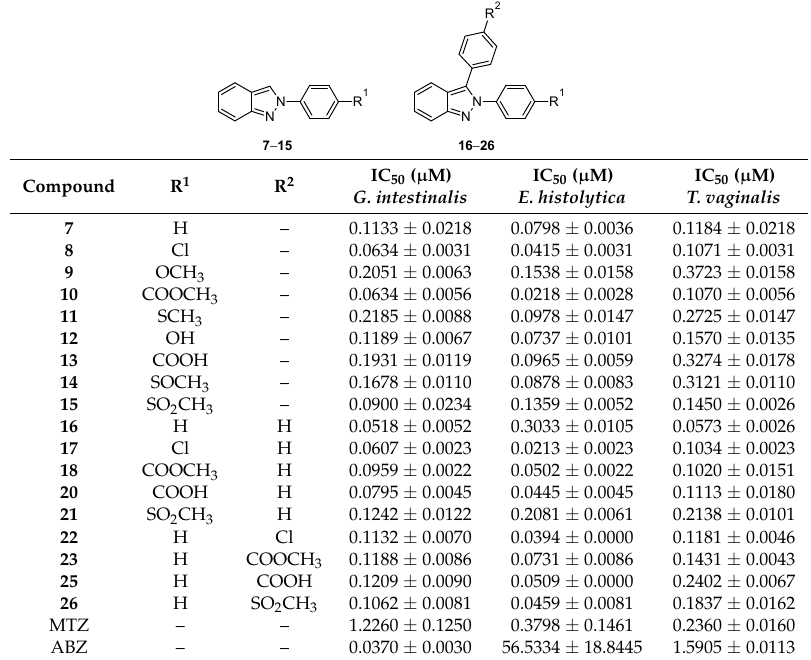
Molecules 2017 , 22 , 1864 Table 1. Antiprotozoal activity of 2-pheny-2 H -indazole derivatives and 2,3-diphenyl-2 H -indazole derivatives. Table 1. Antiprotozoalactivityof2-pheny-2 H -indazolederivativesand2,3-diphenyl-2 H -indazolederivatives.